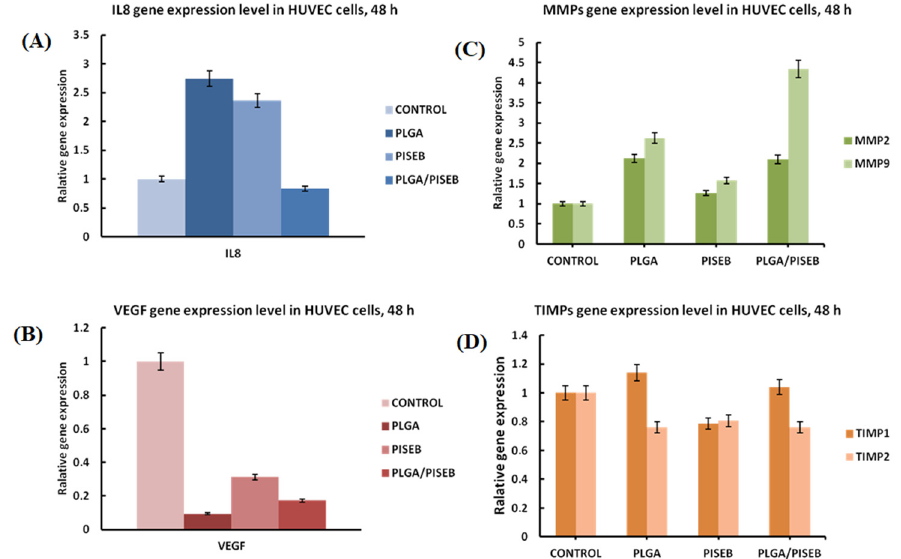
Figure 8. Relative gene expression level, for pro-angiogenic markers IL8 ( A ), VEGF ( B ), MMPs ( C ) and TIMPs ( D ) in HUVEC cells after 48 h of incubation on materials. Data are presented as mean ± SD from 3 experiments.